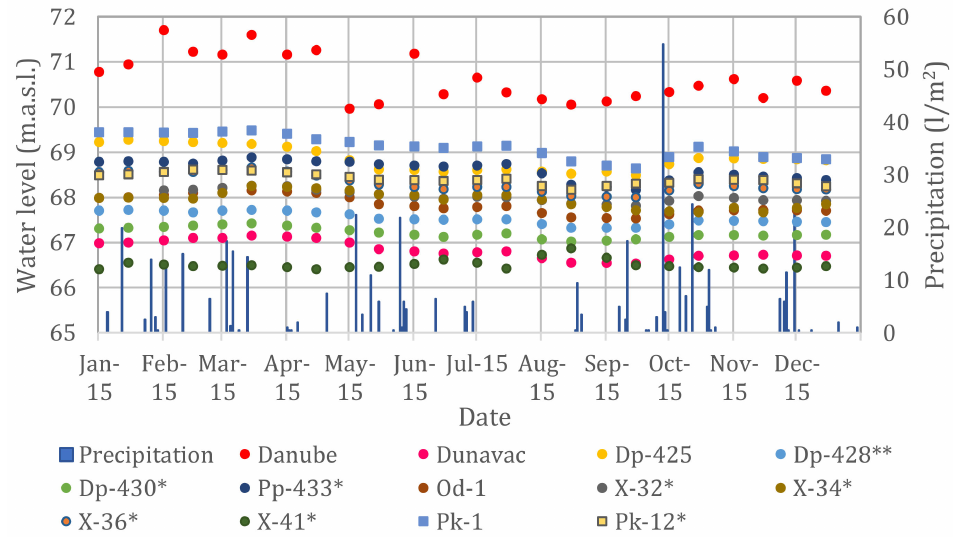
Figure 5. Histogram of daily precipitation totals, groundwater levels of the alluvial aquifer, and stages of the Danube and the Dunavac from 1 January to 31 December 2015. The average effective infiltration was specified as a percentage of the mean monthly precipitation. The initial value was 12% of the precipitation. This boundary condition was assigned only to the first model